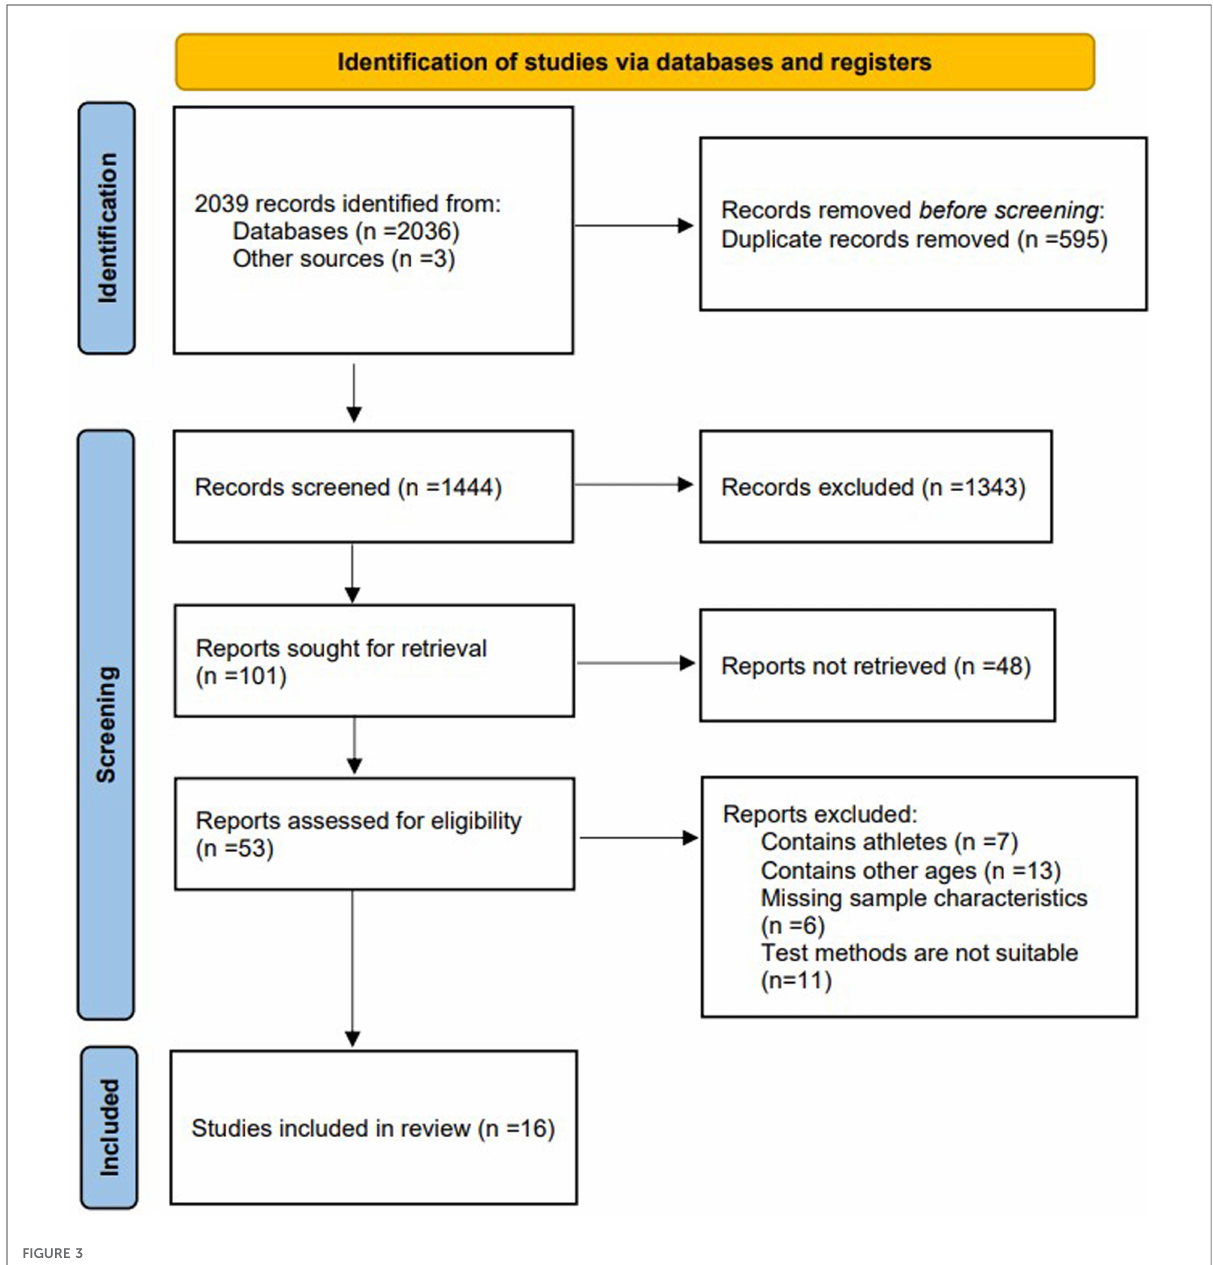
FIGURE 3 Flow diagram of the selected